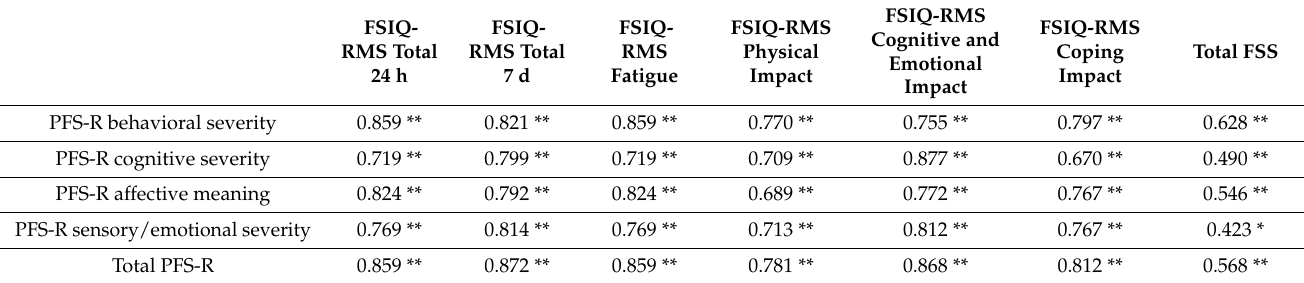
Table 3. Construct validity: Pearson correlation coefficient between the Fatigue Symptoms and Impacts Questionnaire in Relapsing Multiple Sclerosis (FSIQ-RMS), the Fatigue Severity Scale (FSS), and the Revised Piper Fatigue Scale (PFS-R).